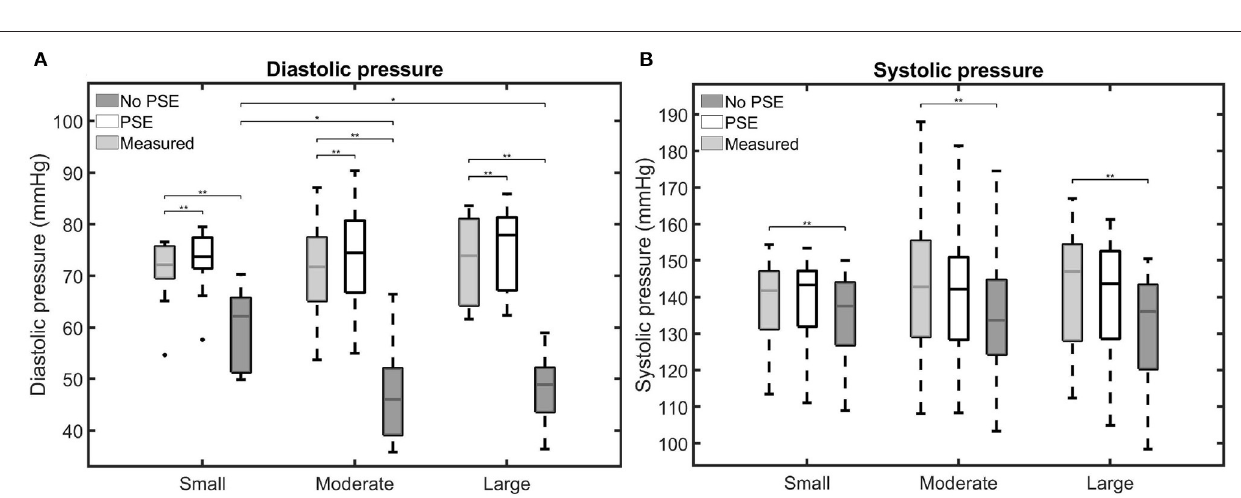
FIGURE 5 | Visualization of the measured and simulated (A) diastolic and (B) systolic blood pressures for the different patient groups. Significant differences between groups are indicated with bars and stars ( ∗∗ p ≤ 1e-2, ∗ p ≤